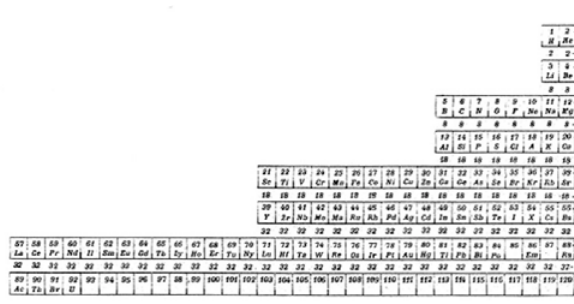
Figure 11. Charles Janet’s table of